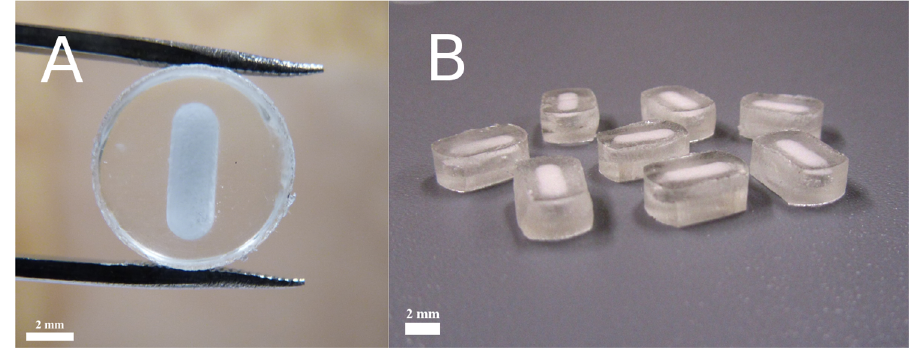
Fig 1. A-B. Top view of a core-shell implant for the in vitro release study (A). Core-shell implants for the in vivo study (B). Oblong cores of 25 mg containing 44 wt-% freeze-dried OVA with inulin (1:10 w/w ratio) and 56 wt-% mannitol were compression-coated with 250 mg of PL(G)A. The final shape ( (cid:25) 5 x 9 mm) of the core-shell implants for the in vivo study was obtained by